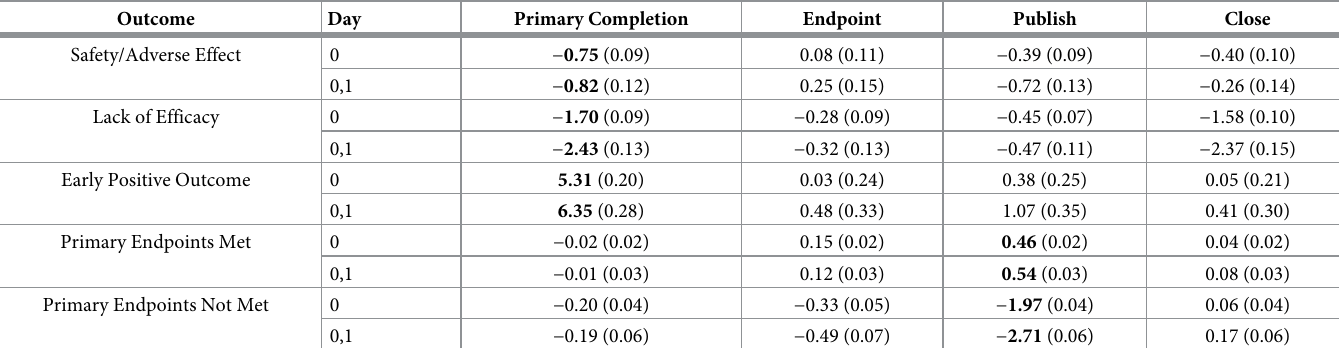
Table 1. Average abnormal returns for different outcome types on various significant